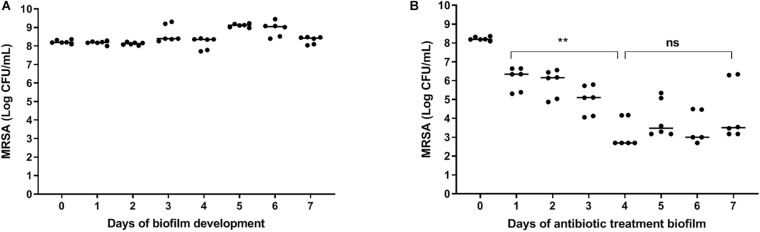
| Effect of antibiotics on bacteria within mature biofilms on polystyrene. (A) The number of bacteria within biofilms on 96-well polystyrene plates remained constant for 7 days. (B) Exposure of a seven-day mature biofilm on 96-well polystyrene plates to rifampicin/ciprofloxacin daily for 3 days, significantly reduced the bacterial load (p = 0.002). Prolonged exposure to rifampicin/ciprofloxacin did not result in further reduction of bacterial counts. The solid line denotes the median log CFU/mL. n = 3 experiments, each in duplicate. ns, not significant.